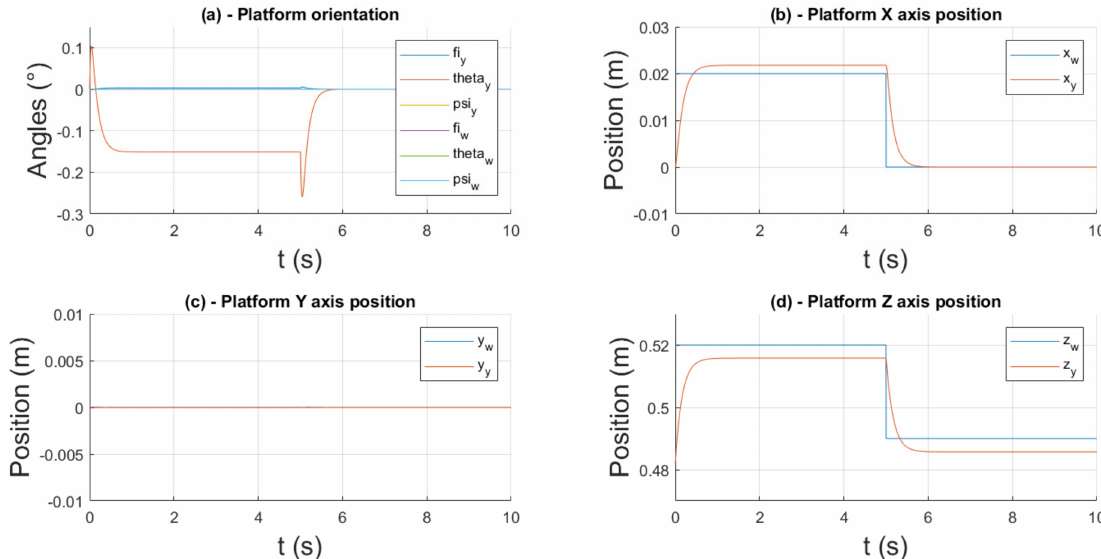
Figure 8. Moving plate position and orientation (MiL). ( a ) Desired ( ϕ w , θ w , Ψ w ) and actual ( ϕ y , θ y , Ψ y ) orientation of the moving plate; ( b ) Desired (x w ) and actual (x y ) position of the moving plate in the X b axis; ( c ) Desired (y w ) and actual (y y ) position of the moving plate in the Y b axis; ( d ) Desired (z w ) and actual (z y ) position of the moving plate in the Z b